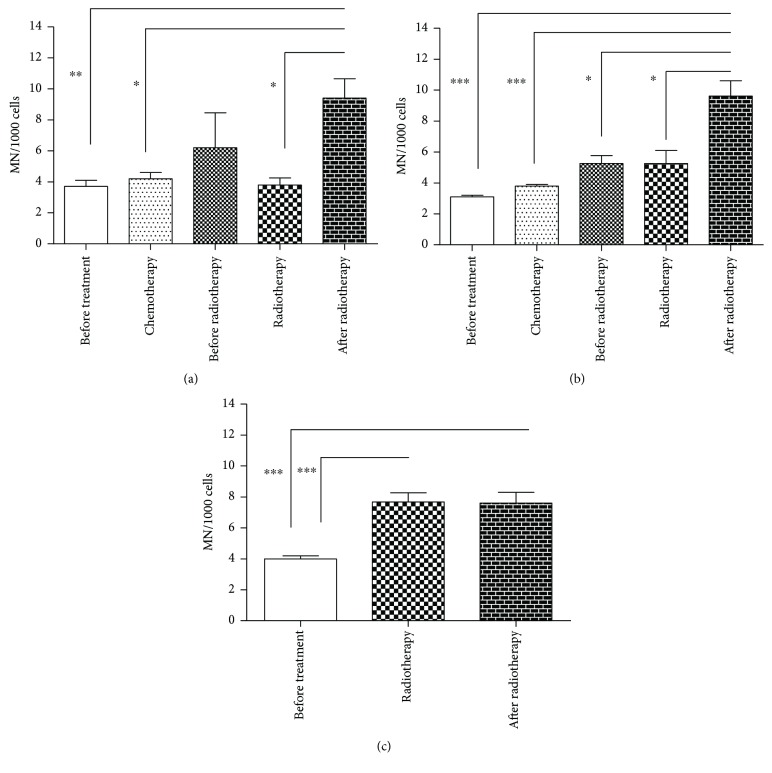
Micronucleus frequency in relation to the therapeutic regimen: (a) FAC, (b) AC, and (c) RT-isolated. ∗Significant at P < 0.05; ∗∗P < 0.01; ∗∗∗P < 0.001 using Kruskal-Wallis test.